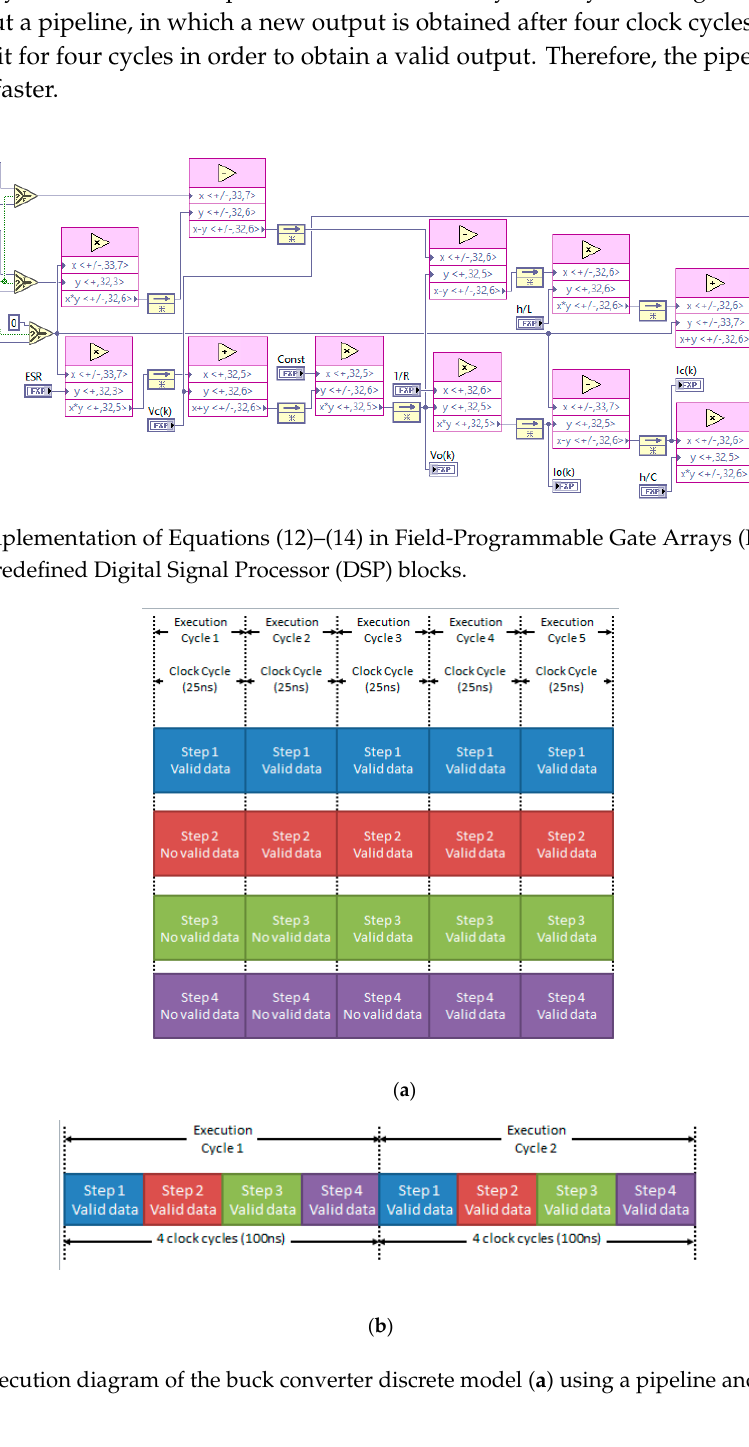
Figure 9. Execution diagram of the buck converter discrete model ( a ) using a pipeline and ( b ) without a pipeline.